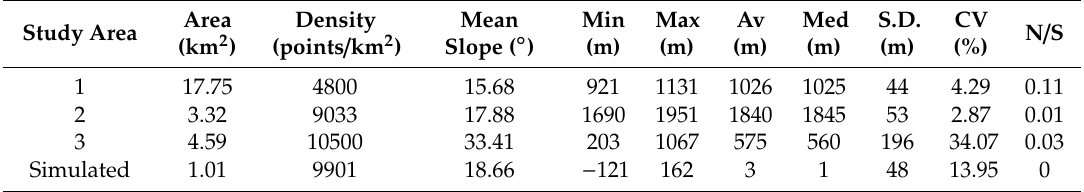
Figure 4. Directional semivariograms of elevations; isotropic semivariograms of ( a ) study area 1, ( b ) study area 2, ( c ) study area 3, and ( d ) simulated data; anisotropic semivariogram (0°) of (a1) study area 1, ( b1 ) study area 2, ( c1 ) study area 3, and ( d1 ) simulated data; anisotropic semivariogram (45°) of ( a2 ) study area 1, ( b2 ) study area 2, ( c2 ) study area 3, and ( d2 ) simulated data; anisotropic semivariogram (90°) of ( a3 ) study area 1, ( b3 ) study area 2, ( c3 ) study area 3, and ( d3 ) simulated data; anisotropic semivariogram (135°) of ( a4 ) study area 1, ( b4 ) study area 2, ( c4 ) study area 3, and ( d4 ) simulated data. Table 1. Slope and general statistics of sampling point elevations in study areas 1–3 and simulated data.